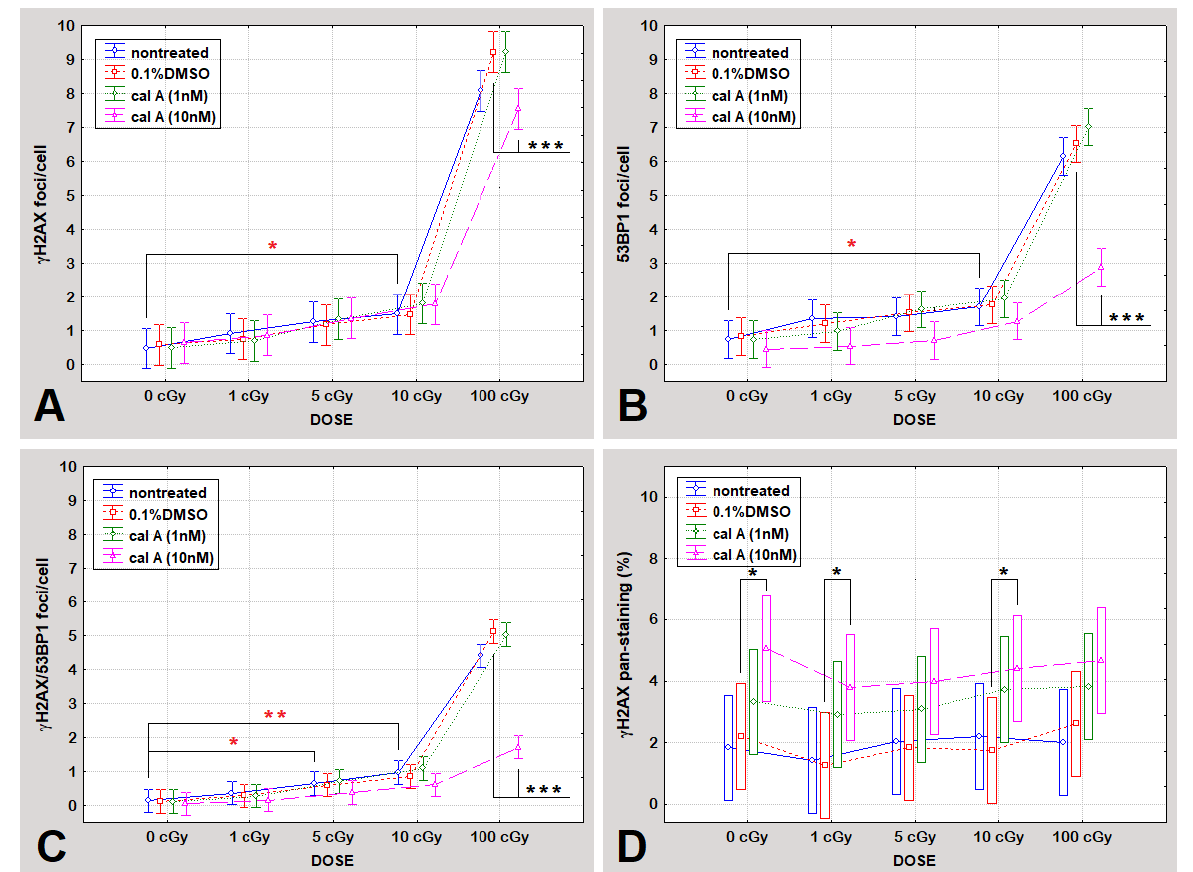
Figure 2. The level of γH2AX foci ( A ), 53BP1 foci ( B ), colocalized γH2AX/53BP1 foci ( C ), and γH 2AX pan-staining ( D ) at 2 h post-irradiation. DNA repair foci levels and percentual rates of γ H2AX pan-staining of differently treated cells (untreated, 0.1% DMSO, cal A (1 nM), and cal A (10 nM)) irradiated with 0, 1, 5, 10, and 100 cGy are shown. Each data point shows the mean value and ± 0.95 confidence interval from 3 experiments. * indicates statistically significant difference between irradiated and unirradiated cells; * indicates statistically significant differences between treatments. * p ˂ 0.05, ** p ˂ 0.0099, *** p ˂ 0.00099.